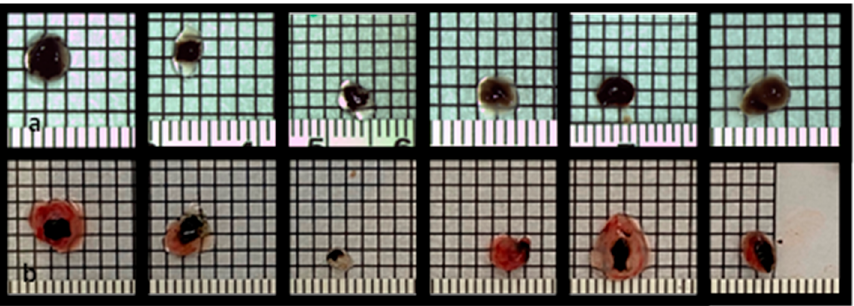
Figure 1. Uveal melanoma patient-derived tumor grafts before implantation onto the CAM on ED7 ( a ) and uveal melanoma nodules on ED18 after dissection ( b ), documentation on a 2 × 2 mm marked sheet.